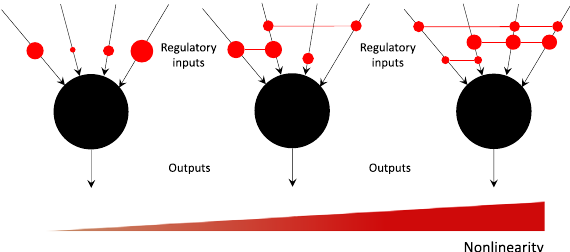
Fig. 1 An illustration of the concept of regulatory nonlinearity. Each black circle represents a generic biochemical component such as a gene, transcription factor, enzyme, etc., regulated by a set of inputs (also biochemical components) and generates a generic output such as concentration level, strength, etc. Non-zero interac- tions among the inputs are represented by red circles connected by red lines, with the total number of possible interactions for a node (cid:2) (cid:3) P k k . The size of the red circles and the with k inputs equal to l ¼ 1 l width of the connecting lines represents the weight of the interactions. Independent inputs are represented by unconnected red circles. The degree of nonlinearity would thus be expected to increase, though not necessarily linearly, from left to right, as the numbers and the strengths of the regulatory interactions increase. One could also visualize these local interactions in a broader network-context as “ hypergraphs ” 46 .